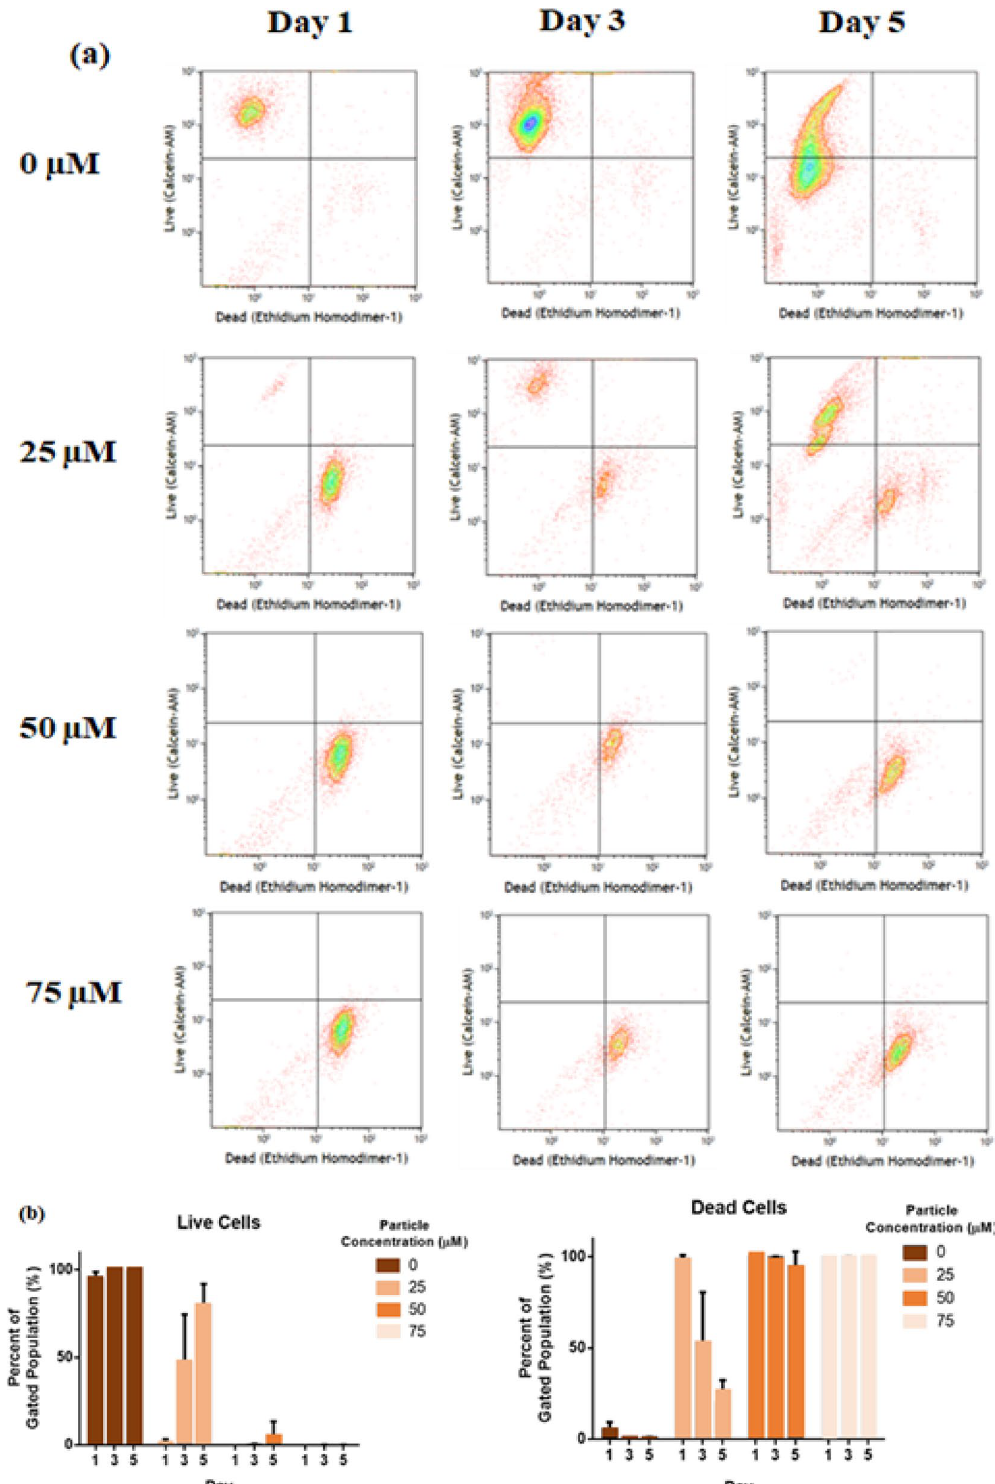
Figure 5. ( a ) Live/dead staining of human cervix epitheloid carcinoma cells after treatment with AgNPs (prepared at pH 9 and 65 °C), ( b ) percentage gated population versus days pH and temperature